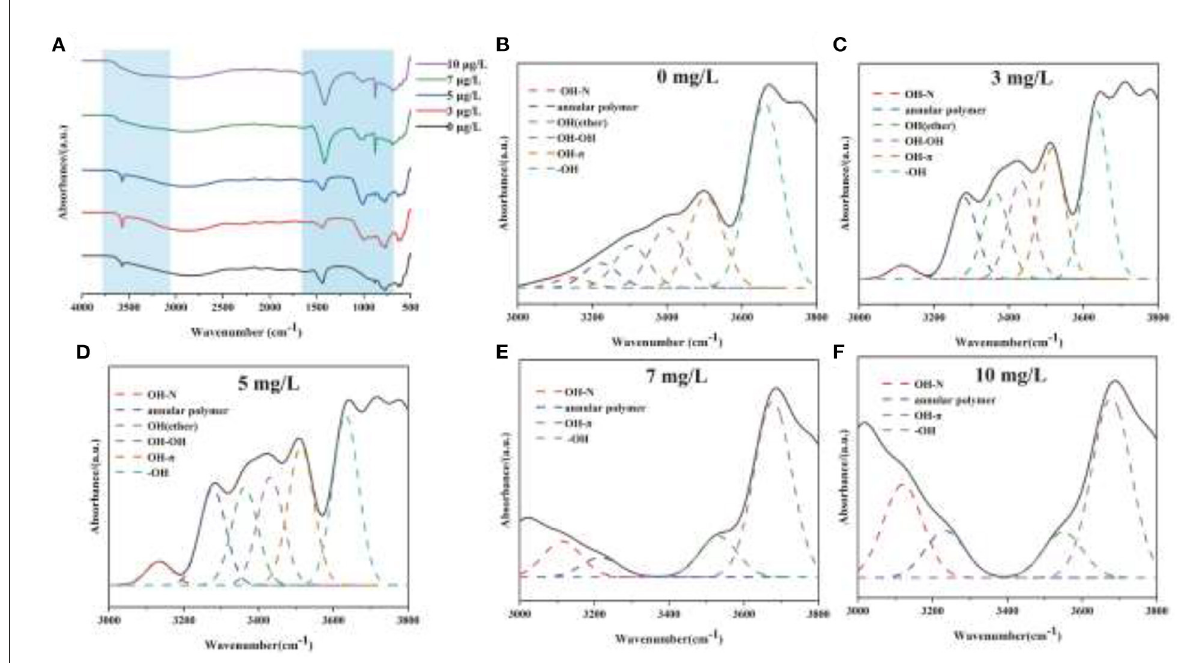
FIGURE7 FT-IR spectra of strain YC-34 under different Cr(VI) stress (A) and their deconvoluted results for 0 (B) , 3 (C) , 5 (D) , 7 (E) , and 10 mg/L (F) at the region (3,000–4,000 cm − 1 ).